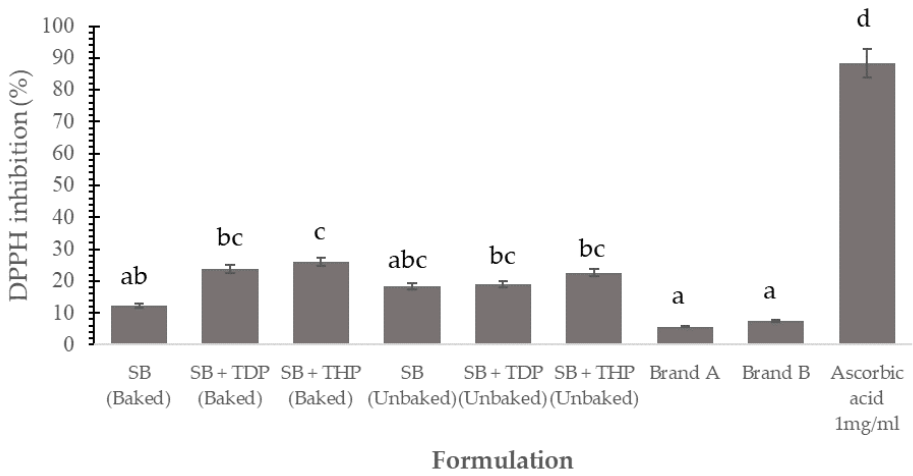
Figure 3. DPPH scavenging activity of snack bar products. Values that contain different letters are Scheme Scheme 0.